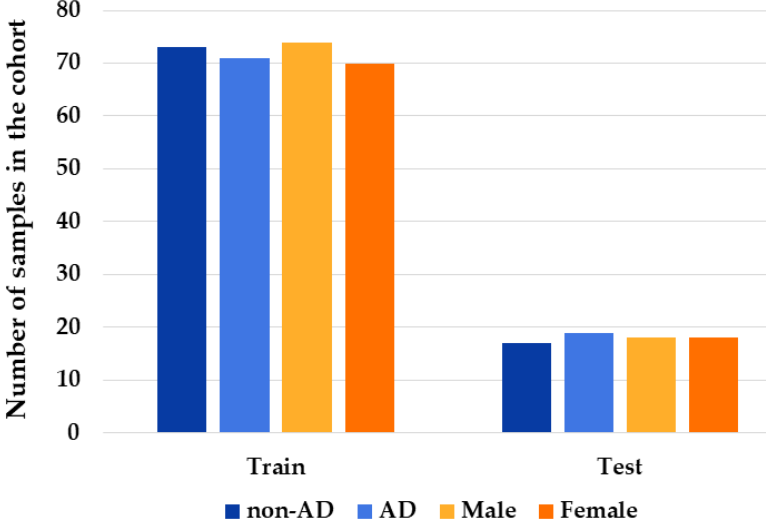
Figure 4. Dataset partition. The bar chart shows the distribution of statistics in training (on the left) and test (on the right) sets. The blue palette identifies the condition (non-AD or AD) of the different individuals. On the other hand, the orange palette shows the gender information (male or female). The chart highlights that the ratios of condition or gender are very similar in the training and test sets. The height of each bar shows the number of samples in the specific category.